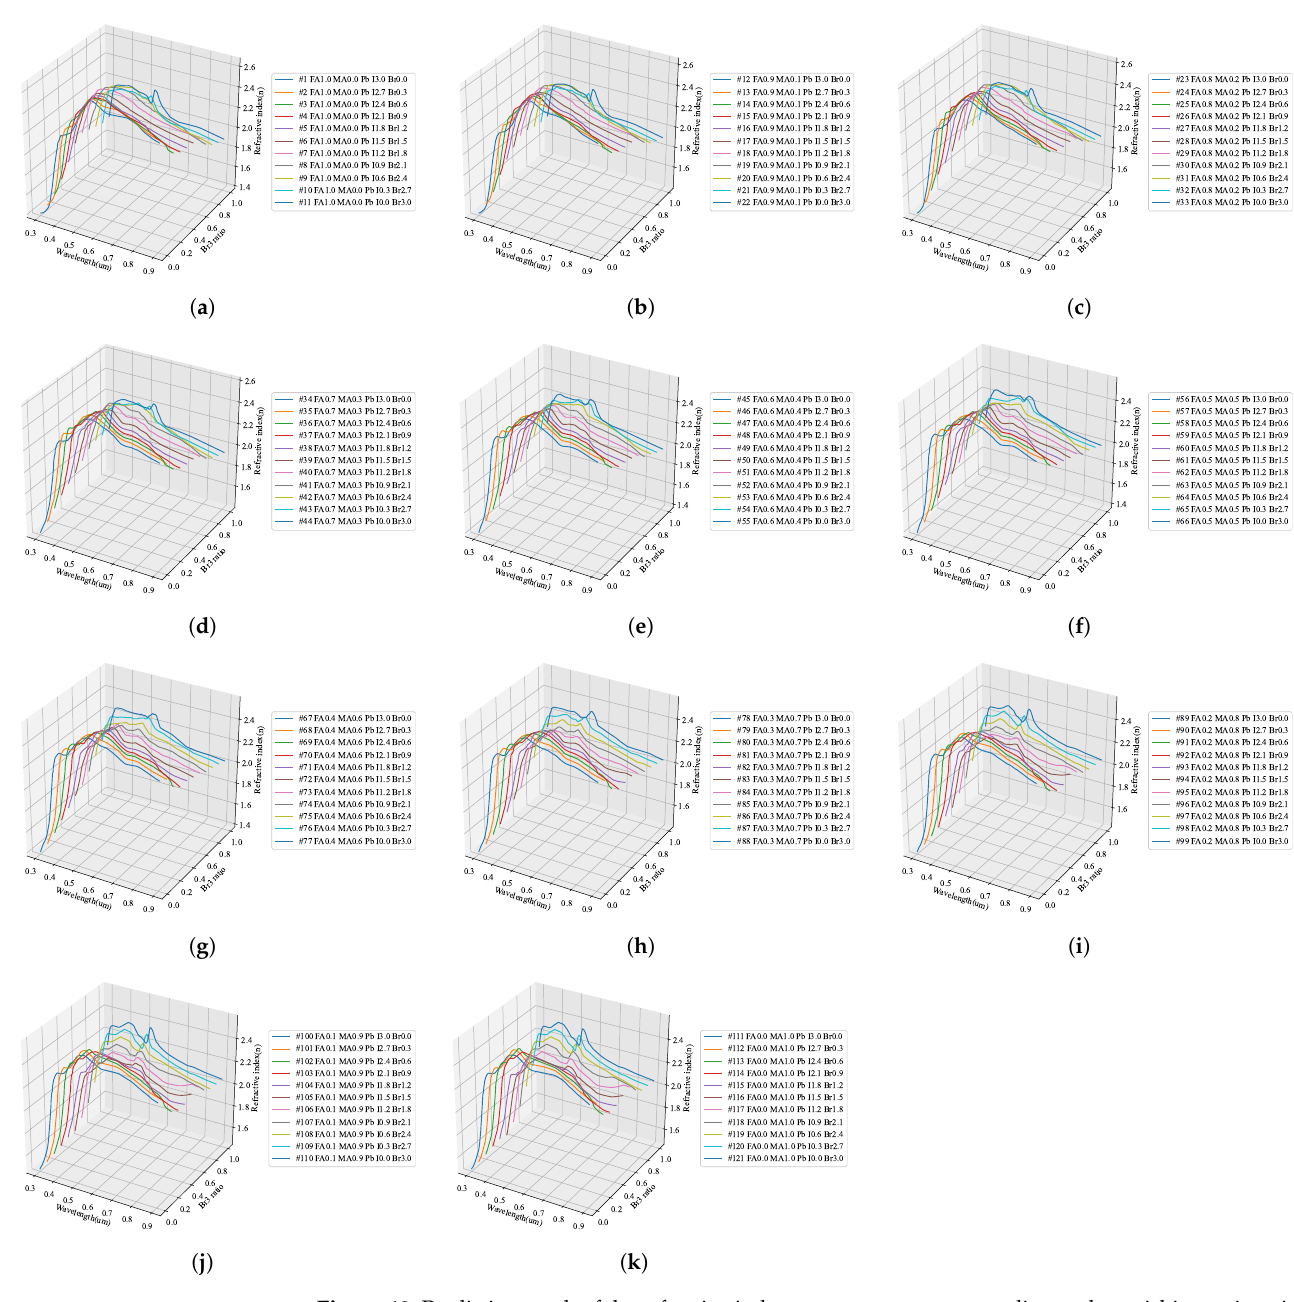
Figure 12. Prediction result of the refractive index spectrum pattern according to the stoichiometric ratio in the direction of increasing Br 3 composition of quaternary perovskite using hyperregression analysis with artificial intelligence: ( a ) FA 1 MA 0 PbI 3